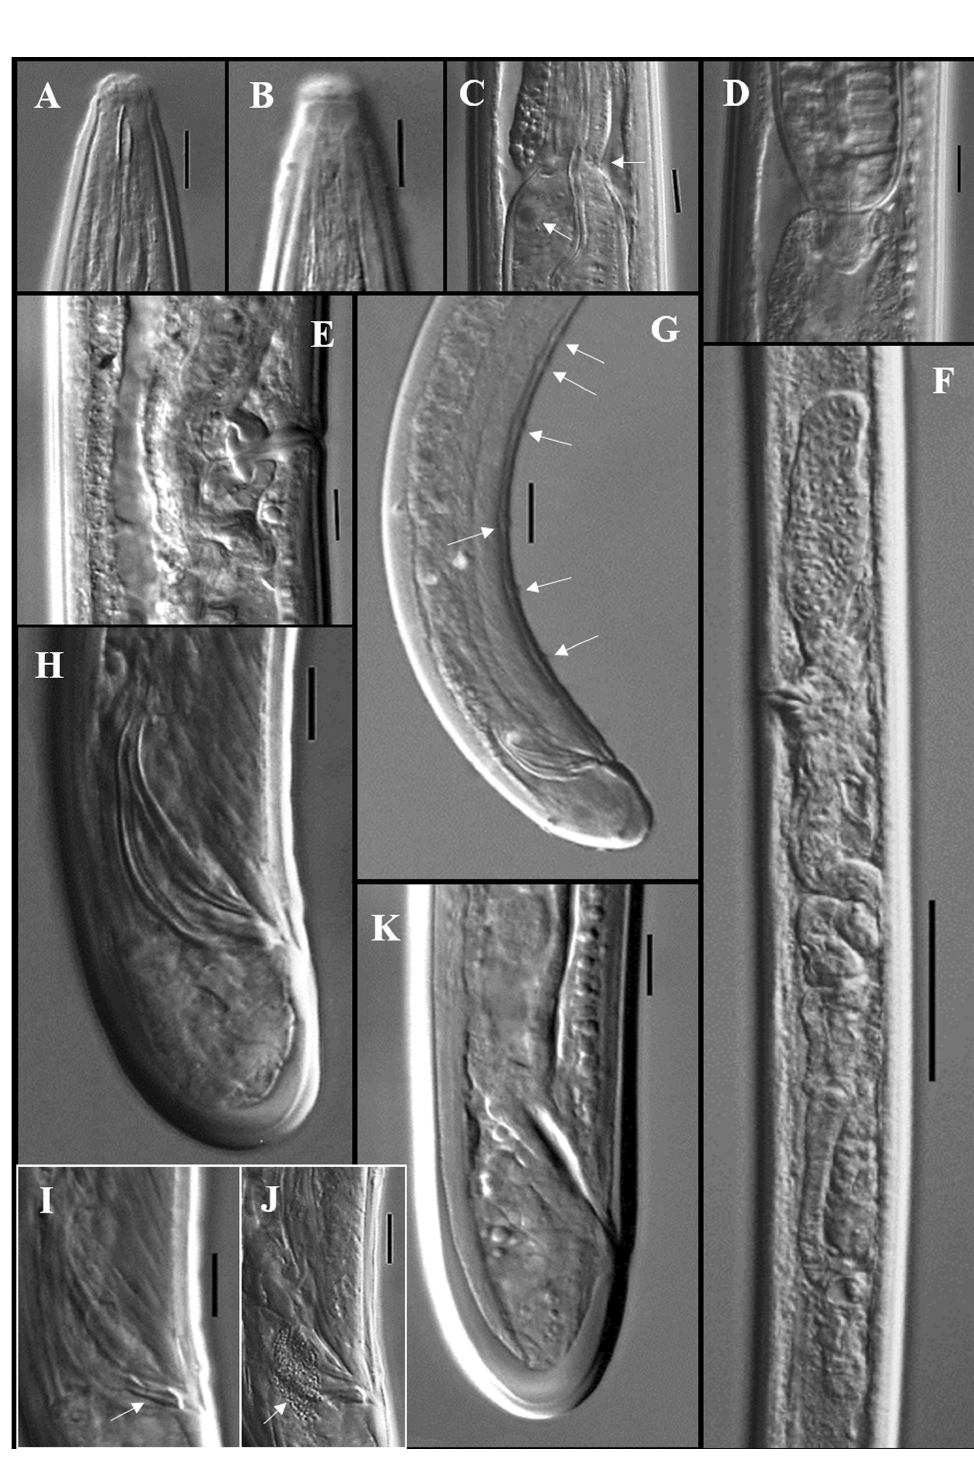
Fig. 3. Axonchium transkeiense Nair, 1973 (LM photographs). A . Anterior region. B . Anterior end showing amphid. C . Junction between two parts of pharynx. D . Cardia. E . Vulva and vagina. F . Female genital branches. G . Ventromedian supplement series. H . Male posterior end. I . Lateral guiding piece. J . Arrow indicating sac-like structure in the male posterior region. K . Female posterior end. Scale bars: A–E, H–K =10 µm; F = 50 µm; G =